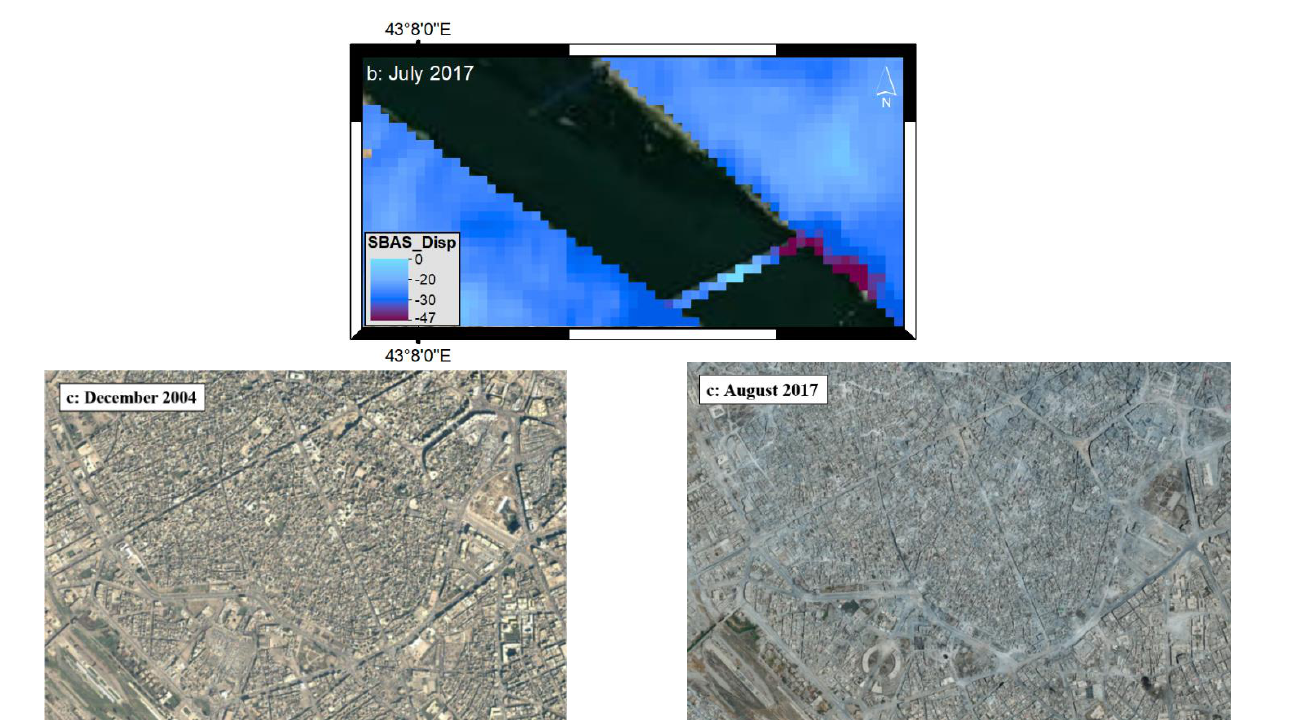
Figure 3. Results of SBAS and PSI damage assessment for Mosul. ( A ) SBAS displacement map and ( B ) PSI displacement map. Positive (negative) values indicate a decrease (increase) in the distance between satellite and objects on the ground. Below the displacement maps are the WorldView-3 (VNIR) high resolution images taken from DigitalGlobe for the purpose of visual comparison of estimated damages in the three selected rectangles. The corresponding zones of “a”, “b” and “c” of SBAS displacement map have also been displayed.